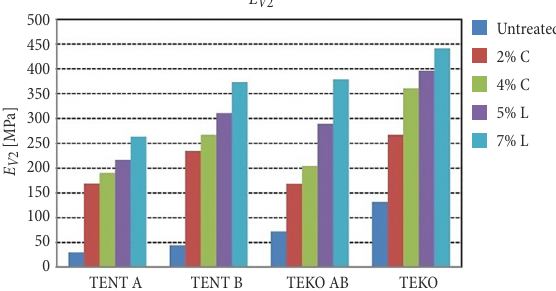
Fig. 7. Modulus of static deformation of tested materials – correlation with CBR according to Gomes Correia